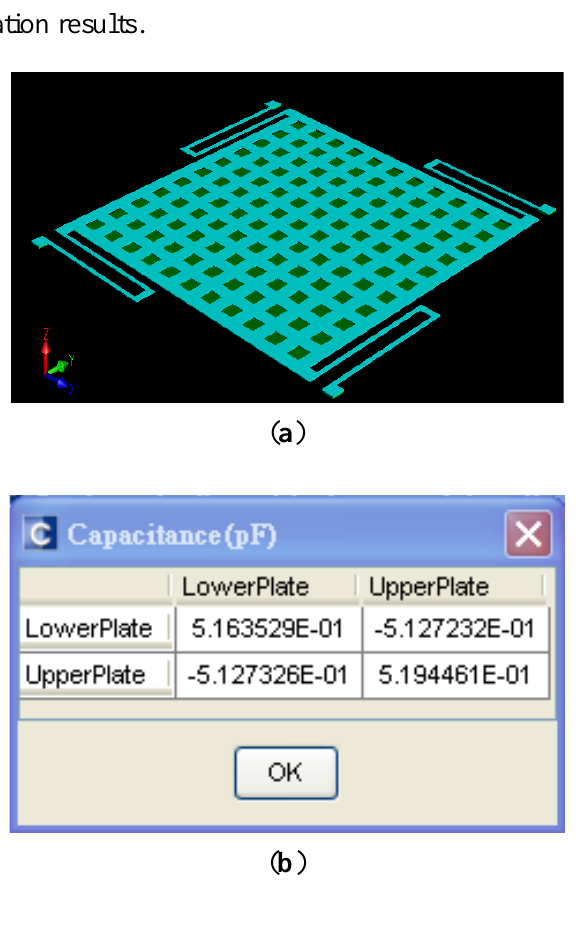
( a ) Solid model of the Ref